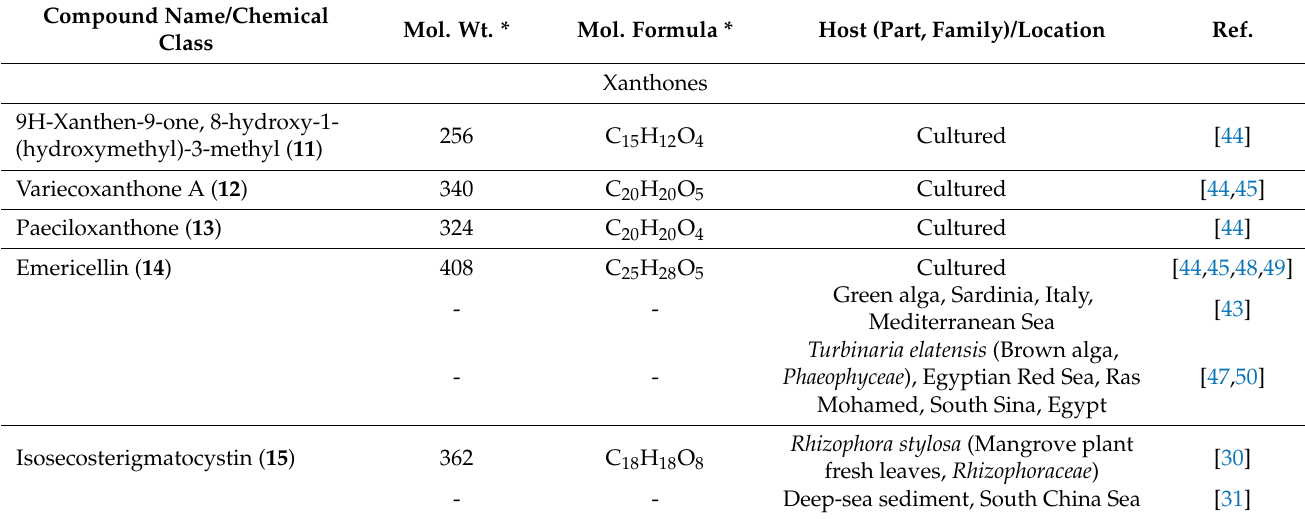
Table 3. Xanthones and quinones reported from Aspergillus nidulans .